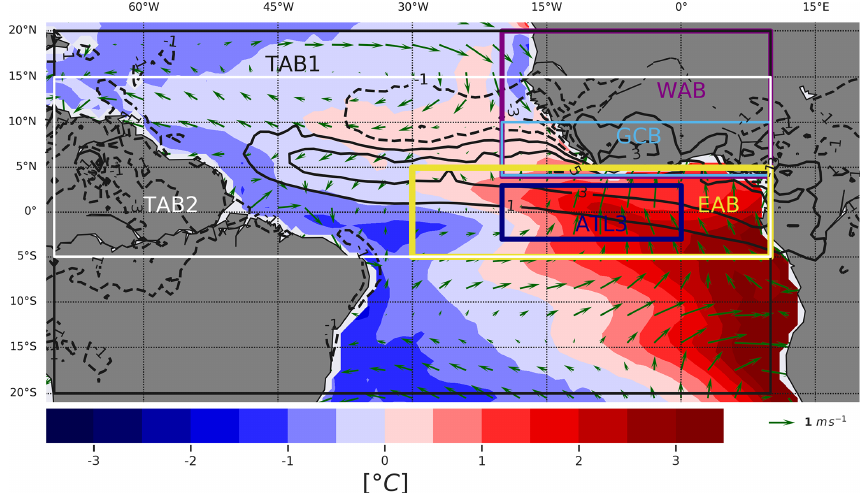
Figure 1. Mean biases (relative to ERA5) of the ensemble mean of the 30 GCMs for the JAS SST (in colours), rainfall (in black contours) and 850hPa wind (arrows) over 1985–2014. Boxes in black, white, yellow, blue, cyan and magenta correspond to the TAB1, TAB2, EAB, ATL3, GCB and WAB regions,